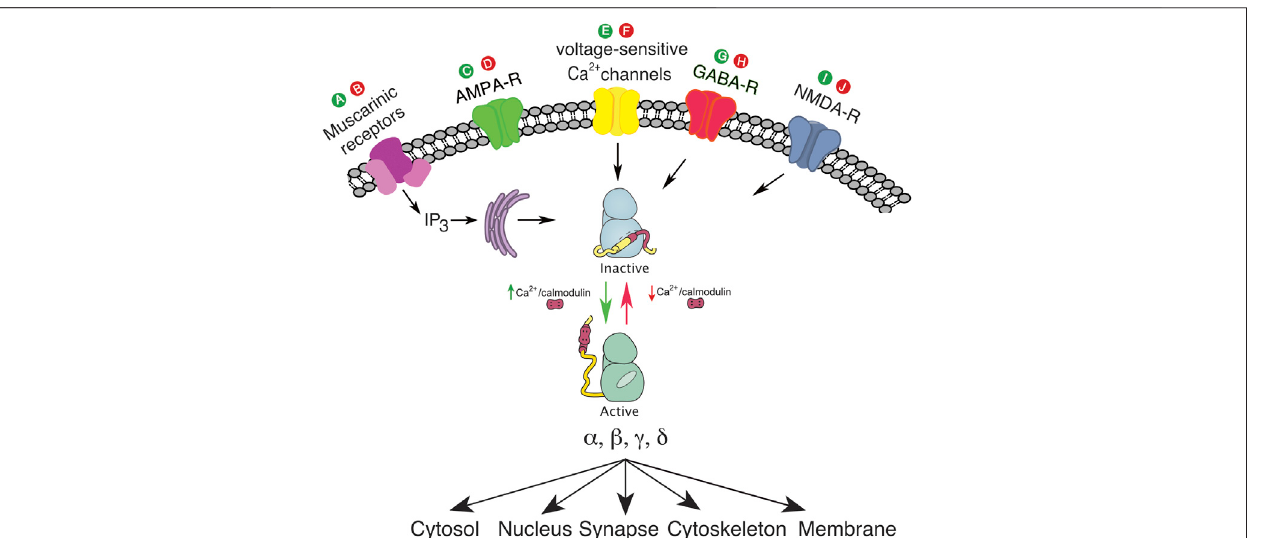
FIGURE 2 | (A) , putative drug to activate muscarinic receptors and IP3; (B) , putative drug to inhibit muscarinic receptors and IP3; (C) , putative drug to activate ionotropic AMPA-R; (D) , putative drug to inhibit ionotropic AMPA-R; (E) , putative drug to activate voltage sensitive calcium channel; (F) , putative drug to inhibit voltage sensitivecalcium channel; (G) , putative drug toactivate GABA-R; (H) , putative drug to inhibit GABA-R; (I) , putative drug toactivate NMDA-R; (J) , putative drug toinhibit NMDA-R. The green color denotes agonist activity at a speci fi c receptor, and the red color denotes antagonist activity at a speci fi c